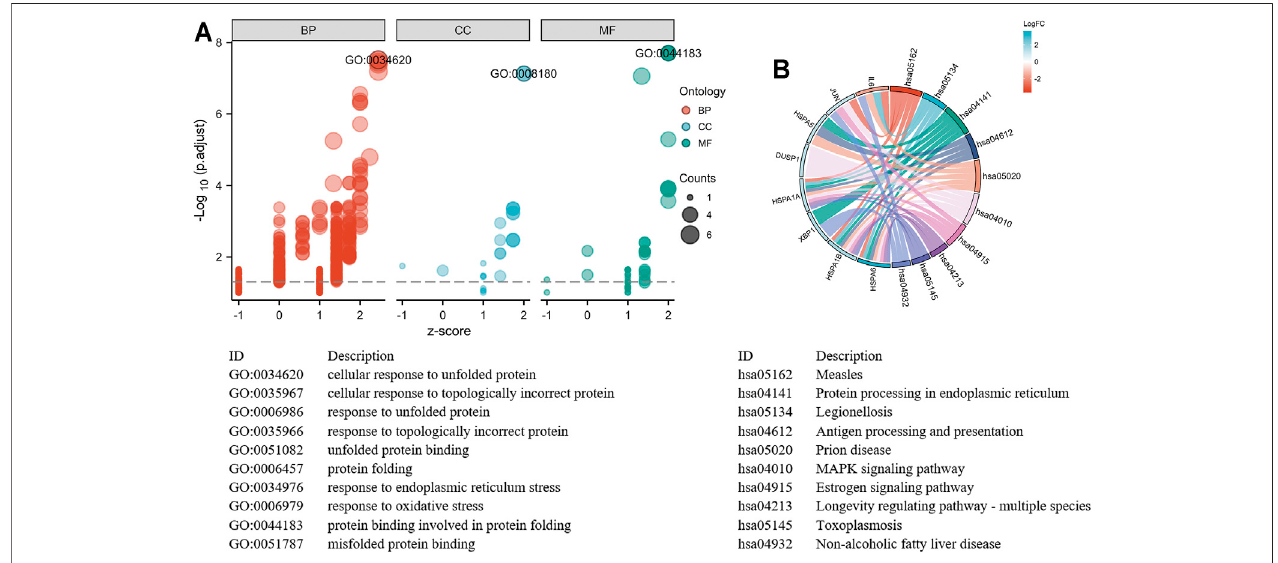
FIGURE 7 | Top 10 hub genes functional enrichment analysis. (A) The GO functional enrichment bubble plot of hub genes. The abscissa represents the z-score, and the ordinate represents the adjusted p -value. The size of the bubble displayed is corresponding to the counts enriched in the GO terms, and the bubble ’ s color correlated with the enriched GO categories. (B) The signaling pathways enrichment chord diagram of hub